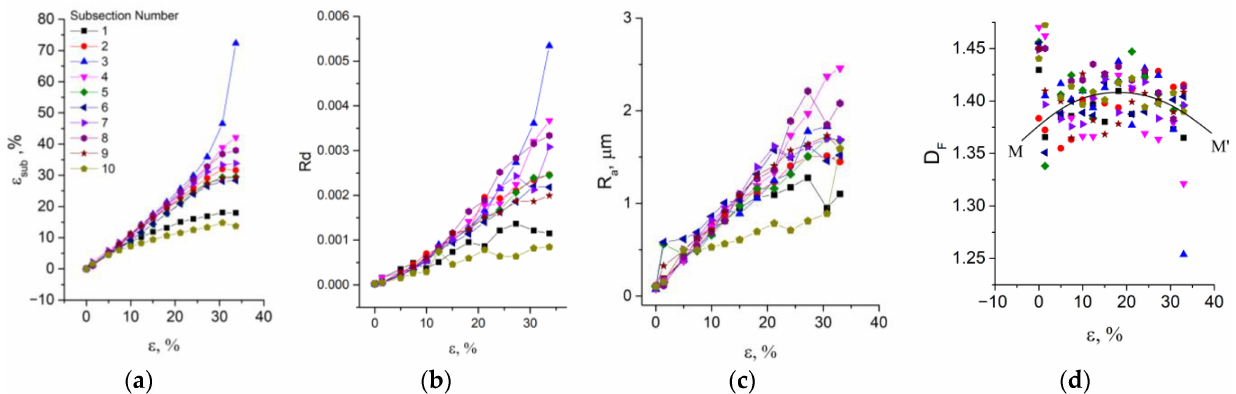
Figure 6. In-plane strains ε sub ( a ), R d and R a roughness parameters ( b , c ) and fractal dimension D F ( d ) for specimen subsections versus specimen tensile